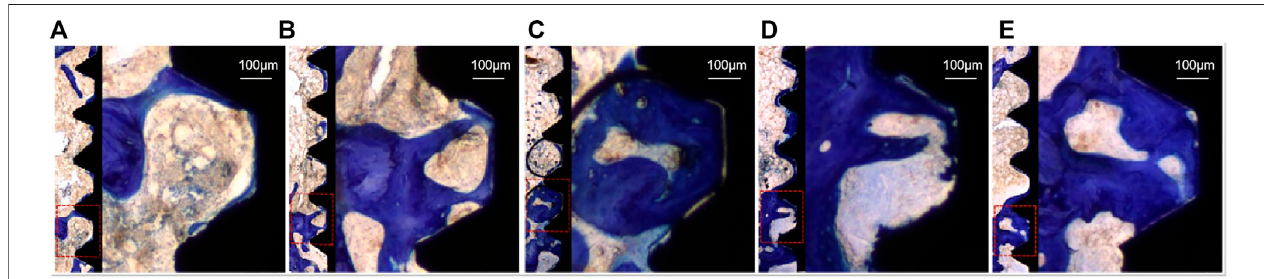
FIGURE10 | Rat femur toluidine blue staining,dark blue part represents new bone tissue. (A) : PT group; (B) : NT group; (C) : WNT group; (D) : KNT-CG group; (E) : KWNT-CG